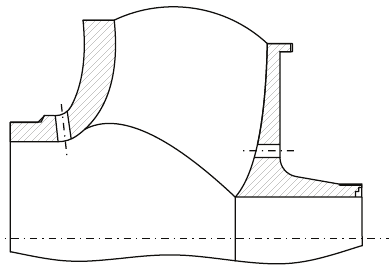
Figure 7: Principle of cavitation